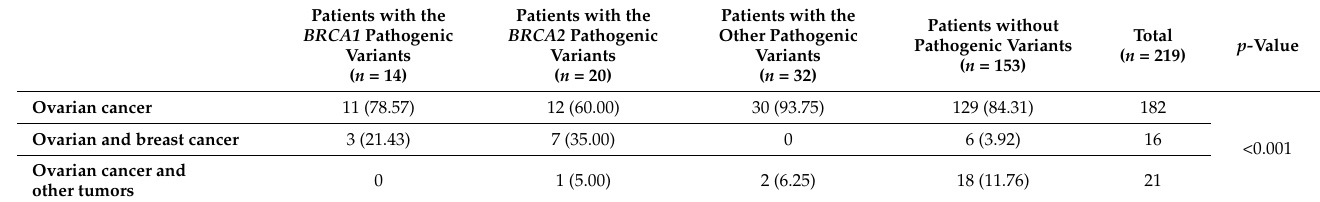
Table 2. Spectrum of tumors according to the mutational status.